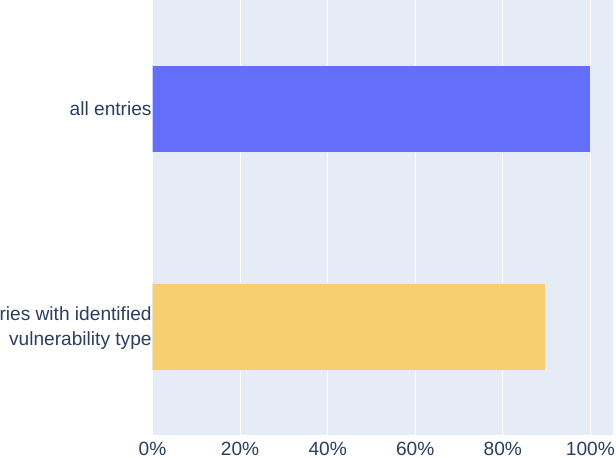
Figure 10. Results of vulnerability type metainformation extraction on data without information about vulnerability type.